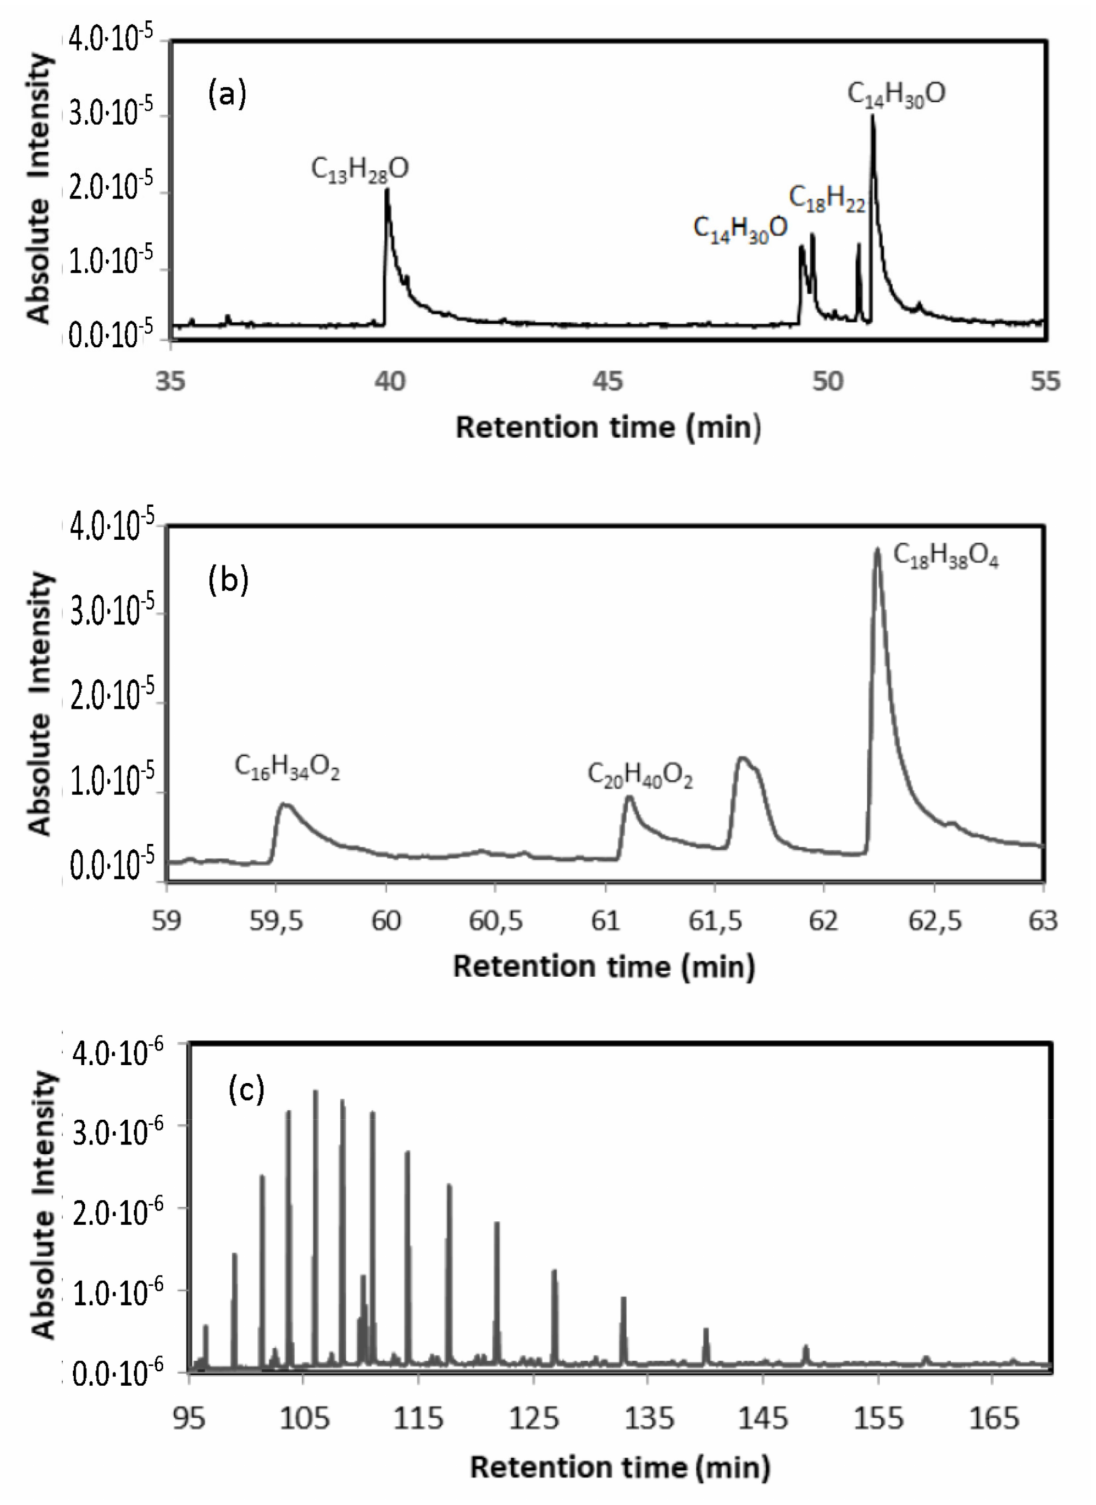
Figure 2. Chromatogram corresponding to the presence of ( a ) 1-Tridecanol (C 13 H 28 O) and 1-Tetradecanol (C 14 H 30 O); ( b ) 1,16-Hexadecanediol (C 16 H 34 O 2 ), Arachidic acid (C 20 H 40 O 2 ) and Tetrahydroxyoctadecan (C 18 H 38 O 4 ); ( c ) presence of long-chain hydrocarbons (C 28 -C 43 ) with increas- ing retention